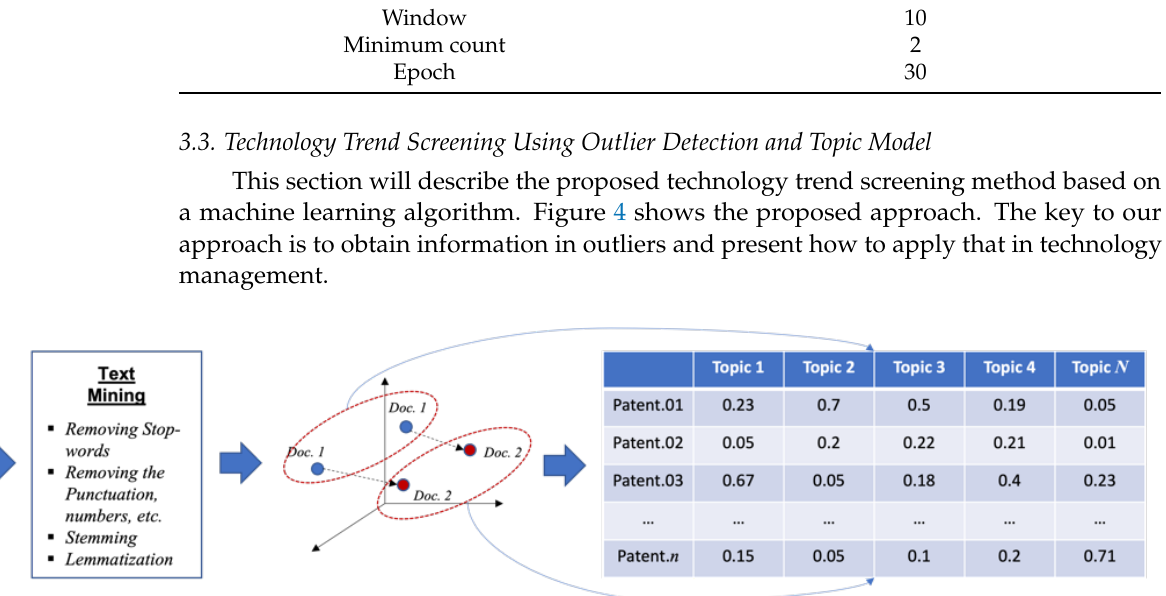
Figure 4. Concept for the Technology Trend Screening.